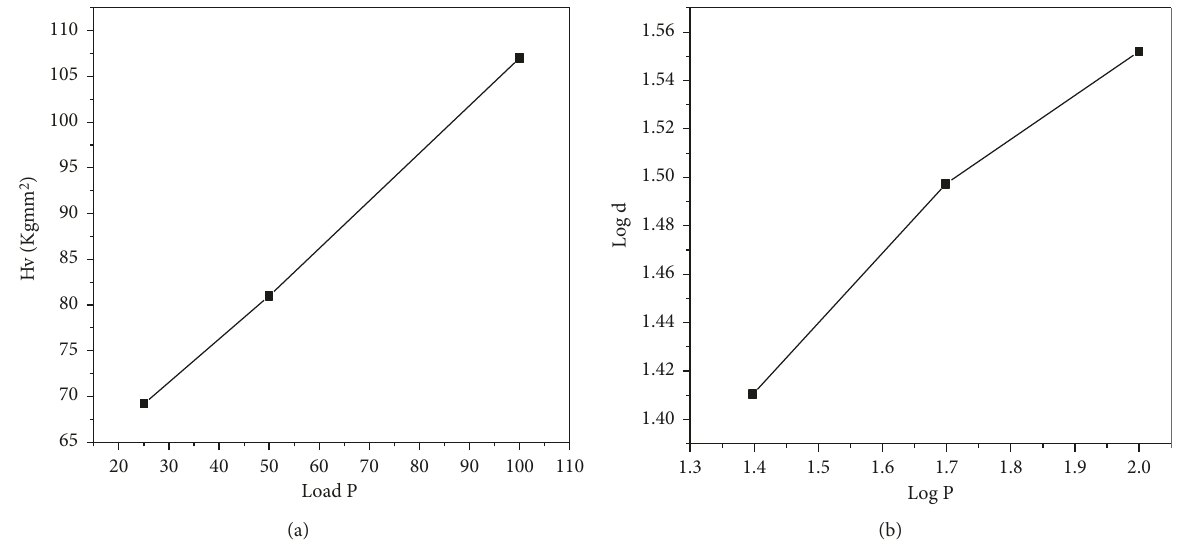
Figure 14: (a) Vickers microhardness. (b) Meyers index plot of BDSC plot of BDSC.